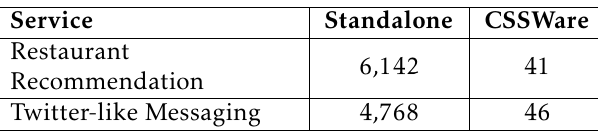
Table 1. Lines of Code Comparison